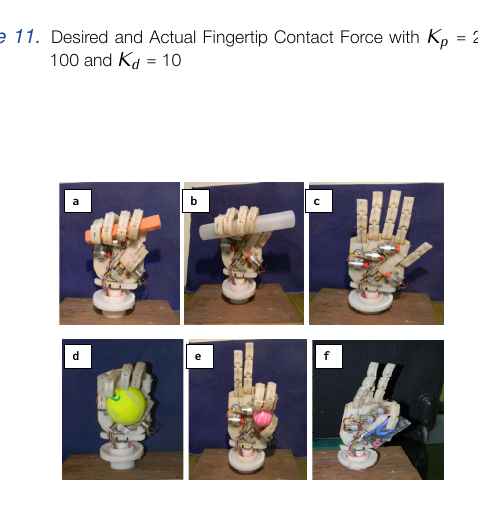
Figure 12. Prototypeperformingsixgrasptypes: a. obliqueb. hookc. palm-up d. power e. precision f. pinch used during 70% of DLA. The posture and/ or number of fingers involved in each grasps are different.